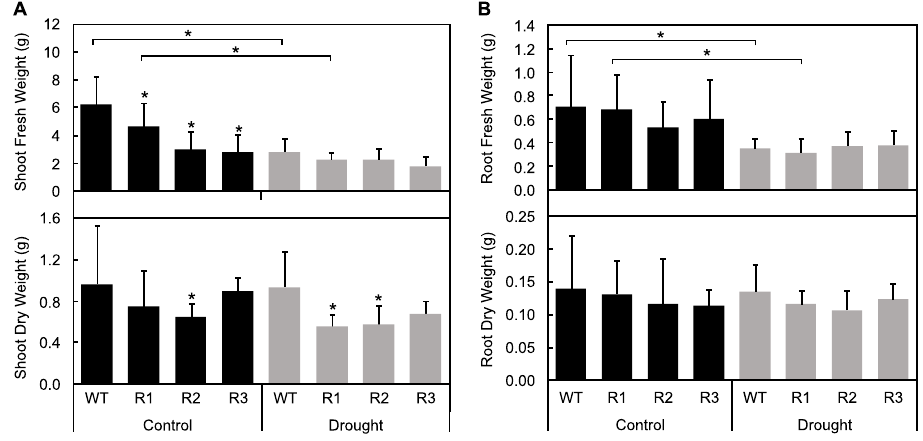
Figure 5. Effect of drought on biomass in WT and SPL9 -RNAi alfalfa: ( A ) aboveground tissue fresh weight (top) and dry weight (bottom) of alfalfa plants after 12 days and ( B ) root tissue fresh weight (top) and dry weight (bottom) after 12 days of drought exposure. The asterisks indicate significant differences within treatments (Dunnett’s test), and the bars indicate significant differences between treatments (Sidak test) in a two-way ANOVA where p < 0.05 and n = 10.